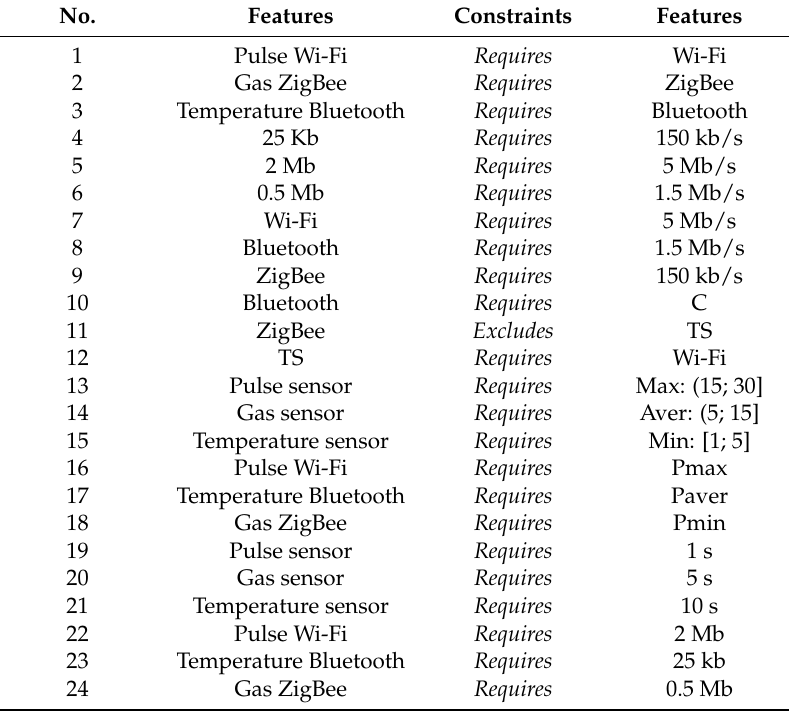
Table 1. Constraint relationships within the feature model (Figure